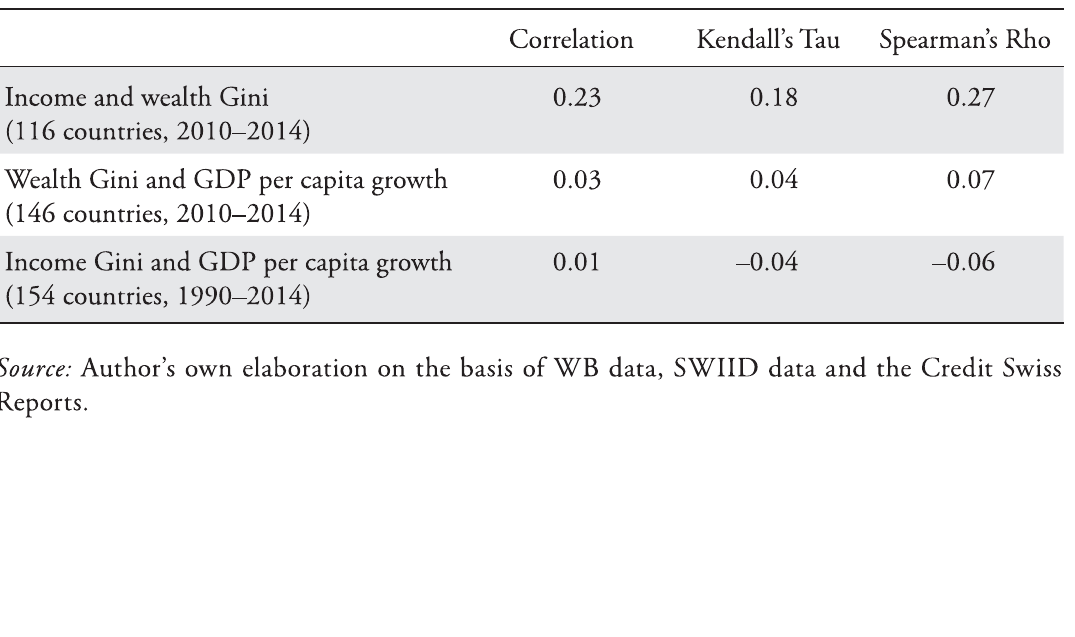
Table 3: Dependence Measures between Income Gini and Wealth